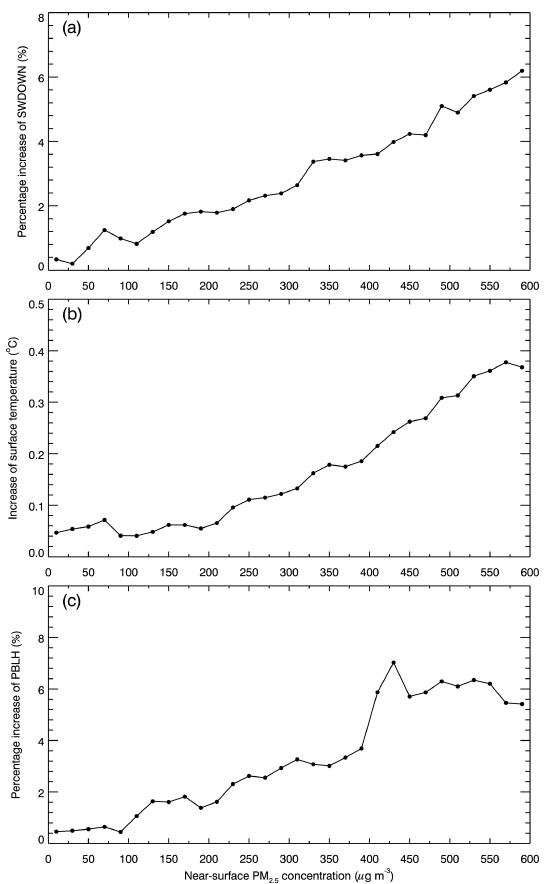
Figure 17. Average (a) percentage increase in SWDOWN at the ground surface, (b) increase in TSFC, and (c) percentage increase in PBLH caused by the ALW-HET as a function of the near-surface [PM 2 . 5 ] in NCP during daytime from 5 December 2015 to 4 Jan- uary